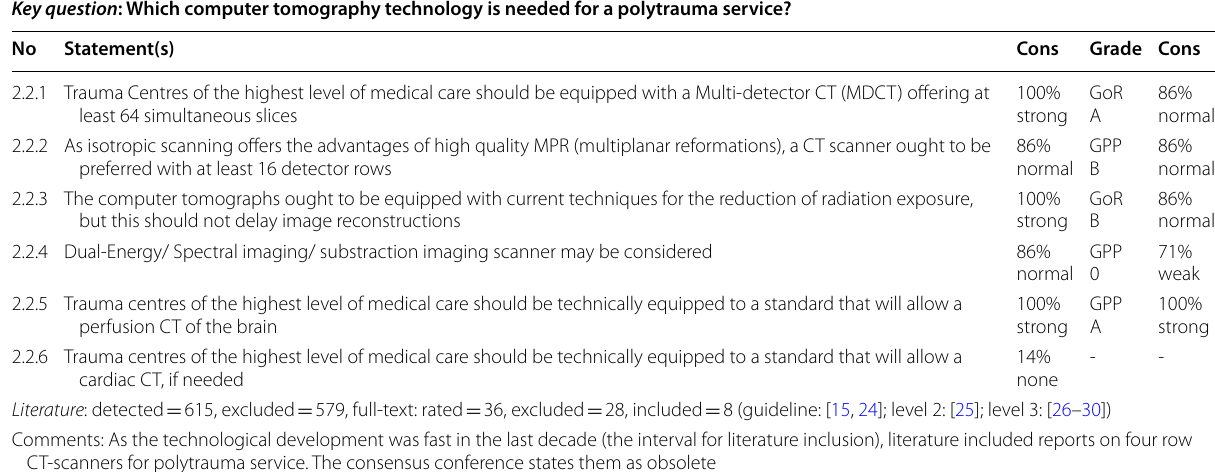
Table 3 Section 2: Structural points, key issue 2: CT type